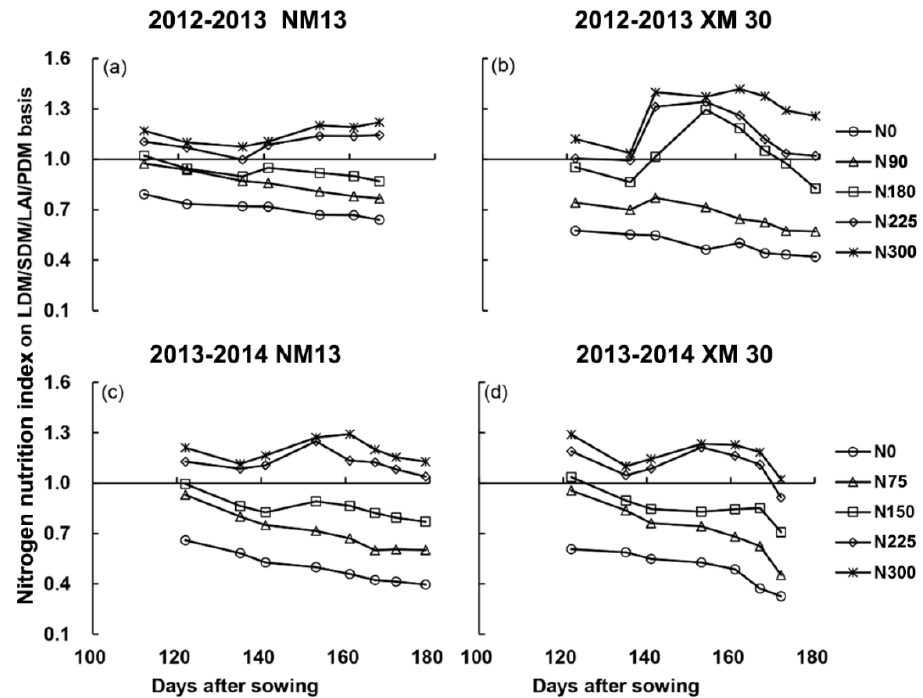
Figure 4. Nitrogen nutrition index (NNI) of wheat at di ff erent growth stages on the basis of di ff erent critical N dilution curves ( a ): leaf dry matter basis; ( b ): stem dry matter basis; ( c ): plant dry matter basis; ( d ): leaf area index basis).